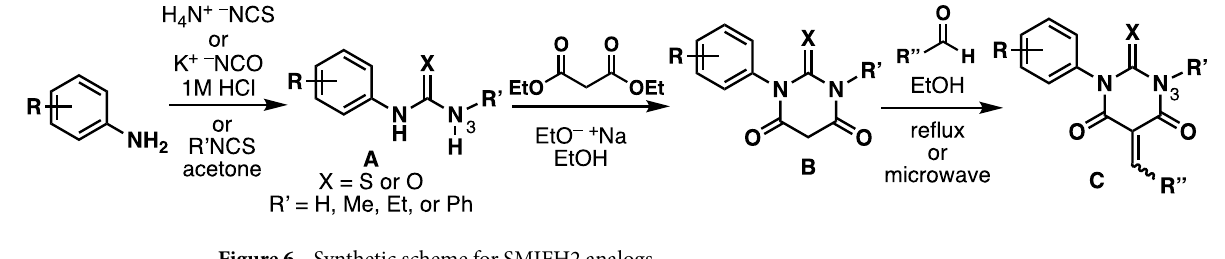
Figure 6. Synthetic scheme for SMIFH2